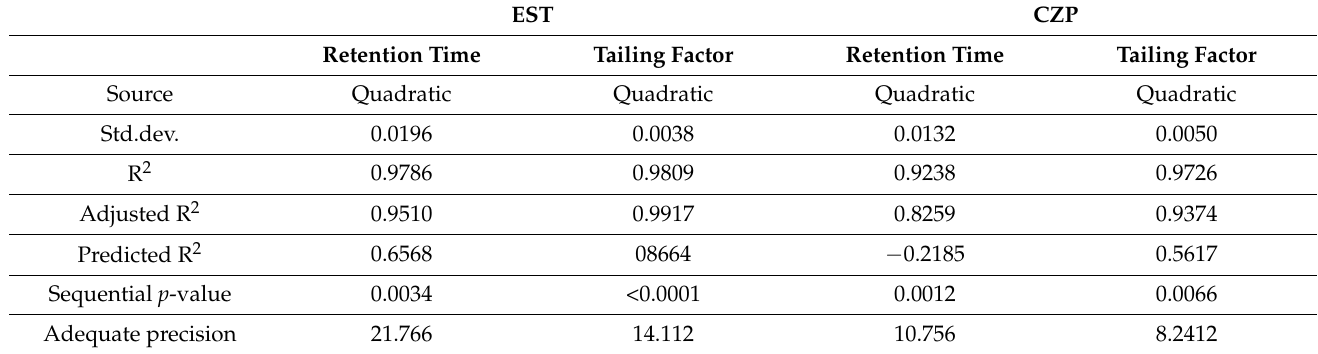
Table 2. Model summary